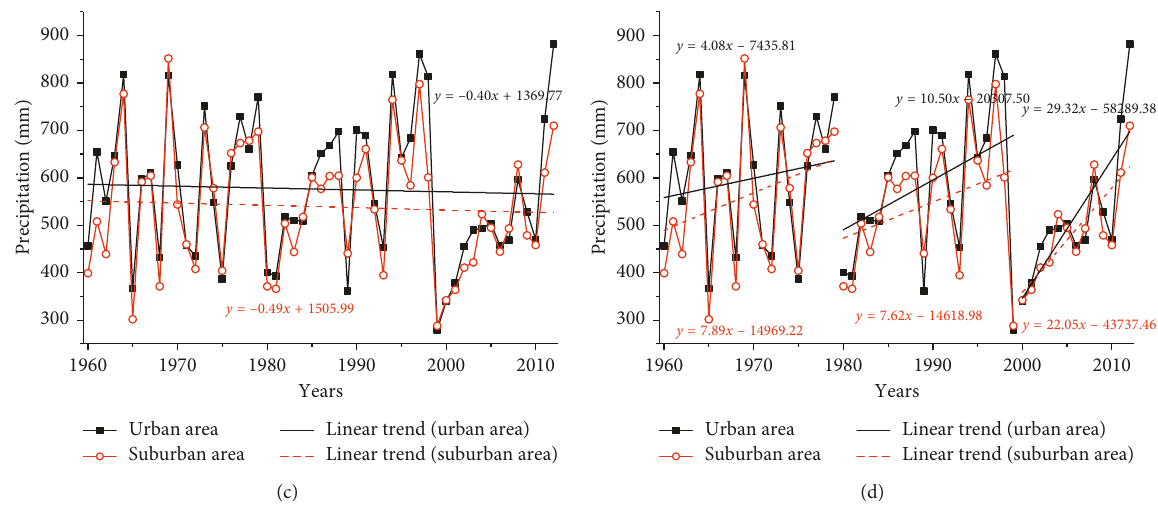
Figure 11: Time series of annual mean precipitation in the plain and mountain areas (top panel) and the urban and suburb areas (bottom panel). The linear trend analyses are discussed based on the different periods: one (left panel) is based on the whole period (1960–2012) and another one (right panel) is based on the three subperiods (1960–1979, 1980–2000, and 2001–2012) considering the different urban expansion stages. Table 7: Comparison of mean precipitation in the different subregions and periods. Plain